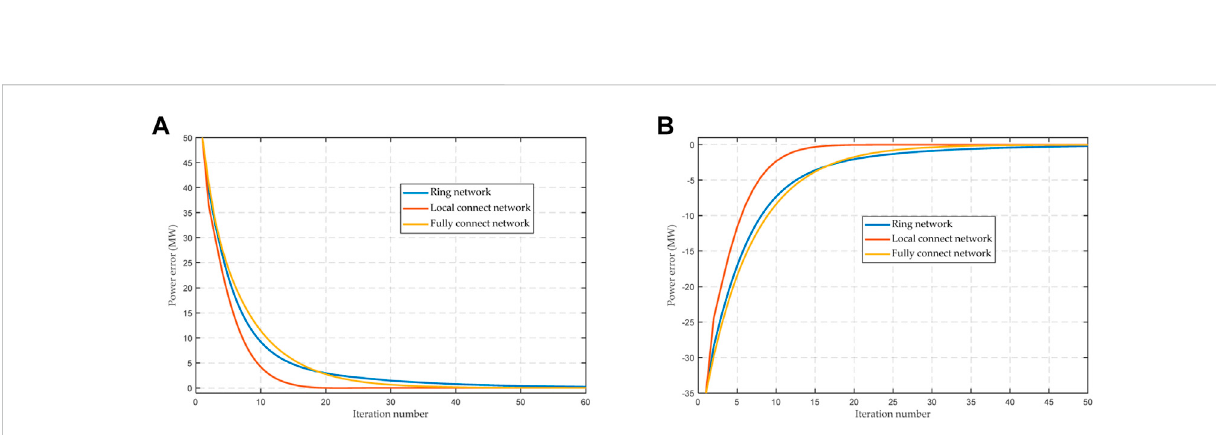
FIGURE 6 Convergence of the DCAA for different communication networks for DT-DPT systems in two scenarios. (A) Δ P C (cid:2) − 80MW. (B) Δ P C (cid:2)